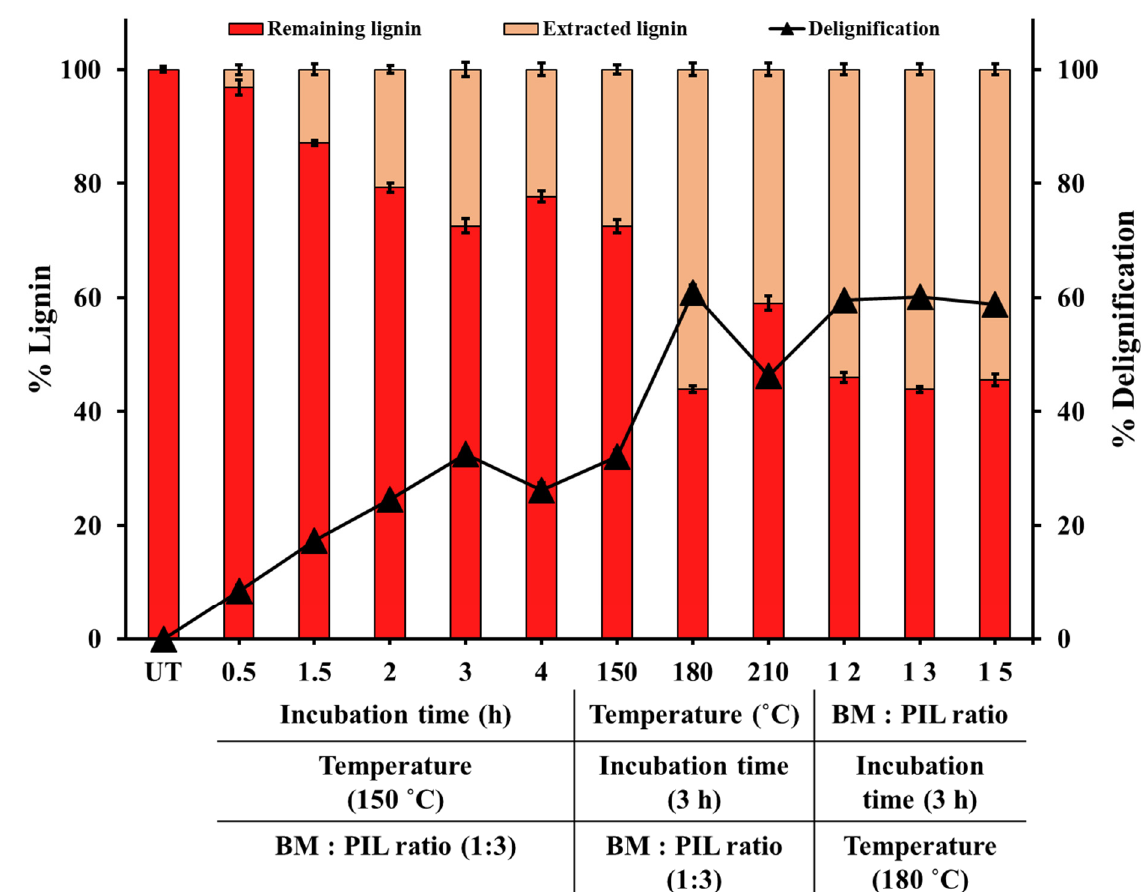
Figure 2. Effect of [N11H(2OH)][LAC] pretreatment on delignification and lignin extraction from pine biomass.